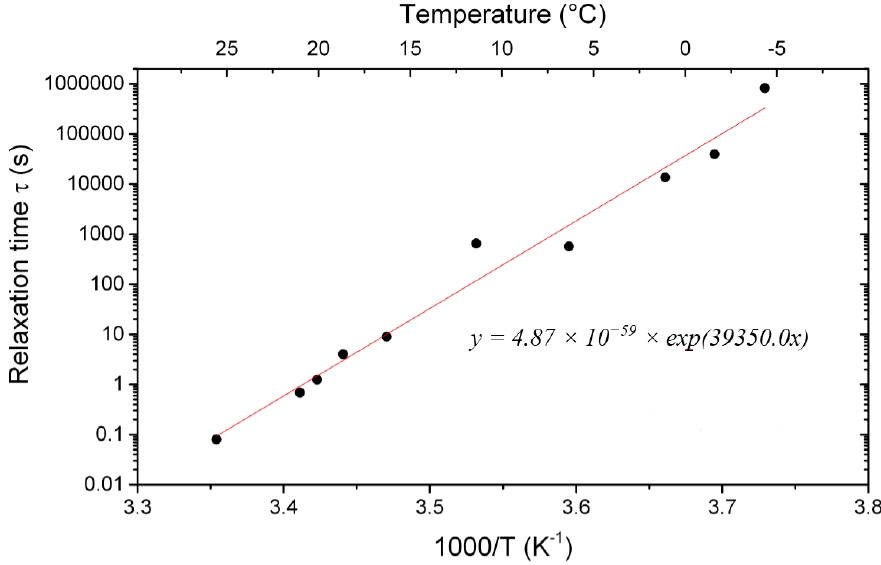
Figure 9. Arrhenius-type dependence of the relaxation time τ